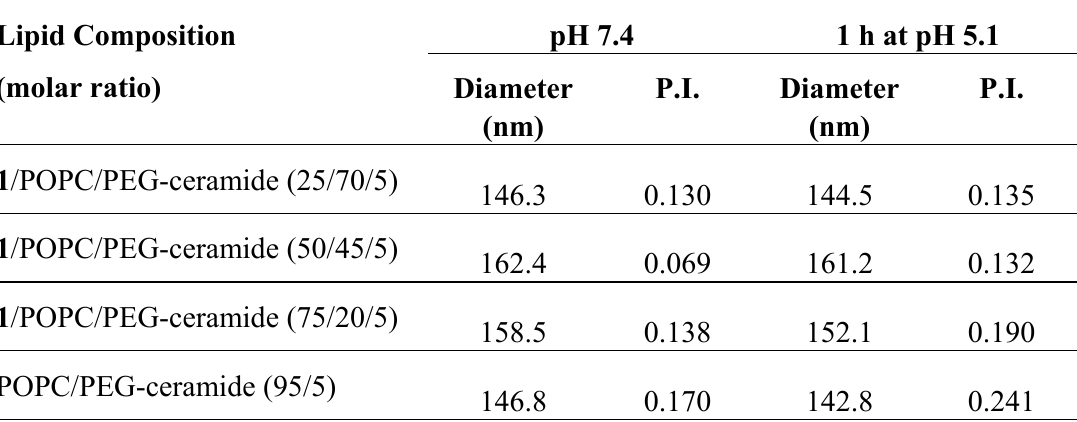
Table 2. Hydrodynamic diameter of 1 /POPC/PEG-ceramide fliposomes at pH 7.4 and after exposure to pH 5.1 for 1